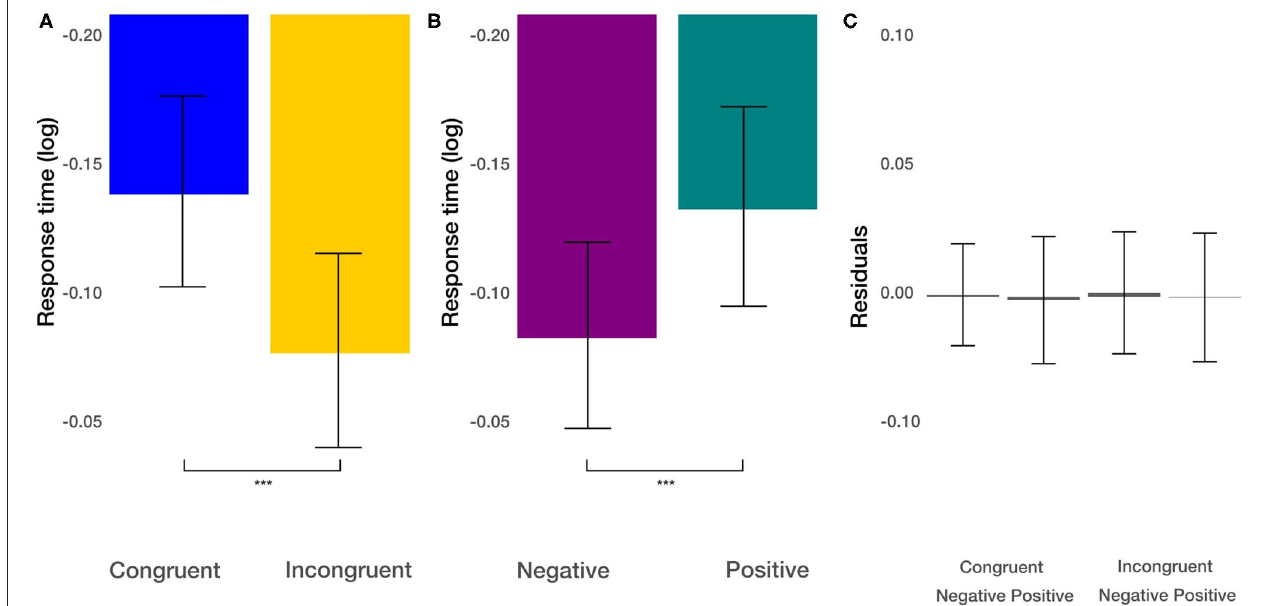
FIGURE 3 | Response time results. (A) The main effect of the congruency of the priming. (B) The main effect of image valence (negative vs. positive). (C) Averaged residuals of all condition combinations from response time linear mixed model. In all plots, bars represent mean values and whiskers standard error of the mean. Stars represent significance levels: *** p <